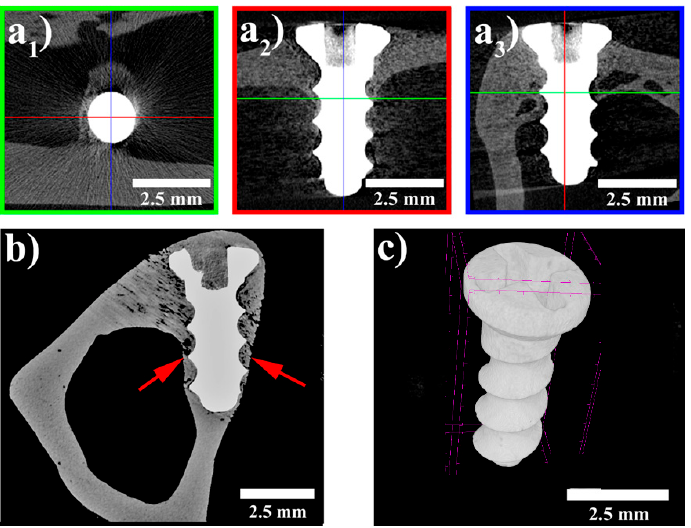
Figure 3. MicroCT images; ( a1 – a3 ) standardised cross-section images in three perpendicular planes; ( b ) implant completely surrounded by bone—arrows; ( c ) 3D visualization of the implanted screw.